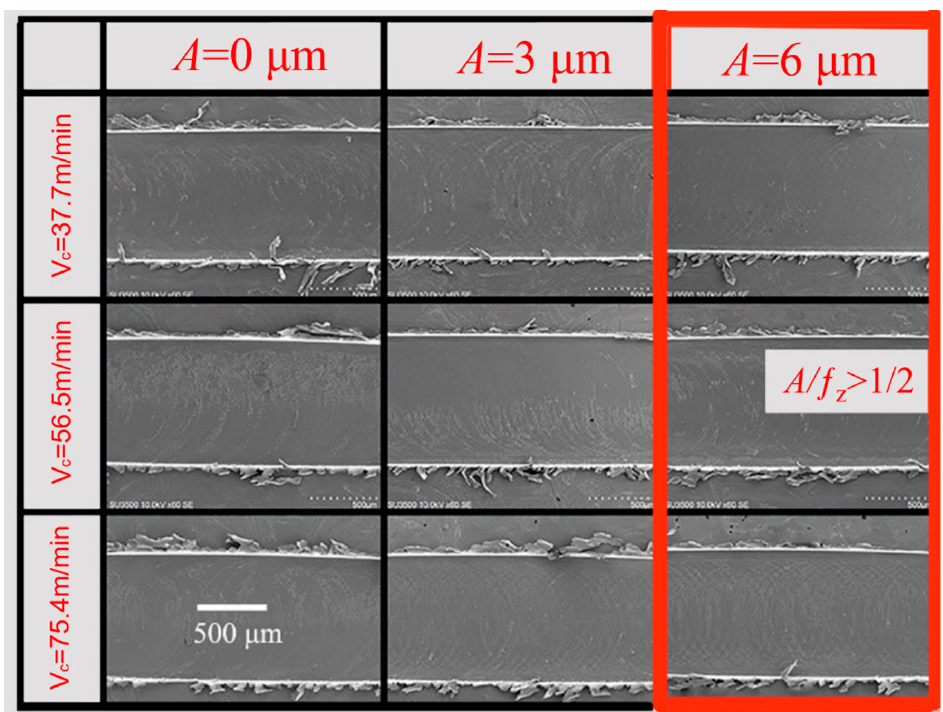
Figure 13. Morphology of burr under different V c (SEM) ( f z = 6 μ m/z, a p = 50 μ m). (3) Effect of ultrasonic vibration on burr formation at different f z .